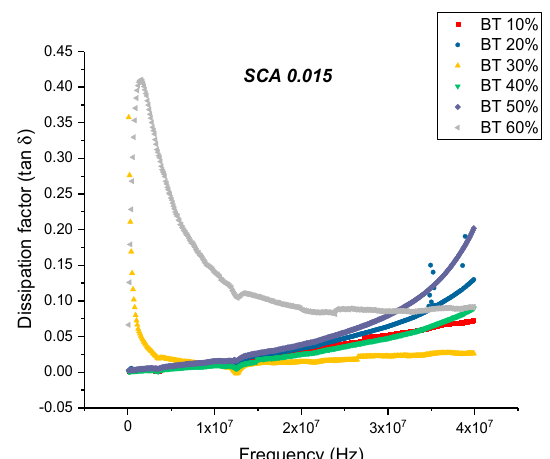
Figure 11. The dissipation factor of the BaTiO 3 -epoxy composite that were fabricated using BaTiO 3 nanoparticles which were surface modified using 0.015 SCA is plotted as a function of frequency where the volume fraction of BaTiO 3 is varied from 0.1 to 0.6. The maximum value is 0.087 for BaTiO 3 at 0.6 volume fraction. The imaginary permittivity increases with the increasing volume fraction of BaTiO 3 nanoparticles and increases with increasing frequency. With increasing frequency, there are fewer contributing factors to the real permittivity do the delayed response of these orientations. This is an almost 21% decrease in dissipation compared to the maximum value exhibited by the composites prepared using SCA 0.01. The decrease in dissipation factor, as previously mentioned, could be attributed to better interfacial bonding between the BaTiO 3 nanoparticles and the epoxy matrix because the coupling agent acts as a molecular bridge between the two, and therefore, contributes to lower conduction losses [80,81].